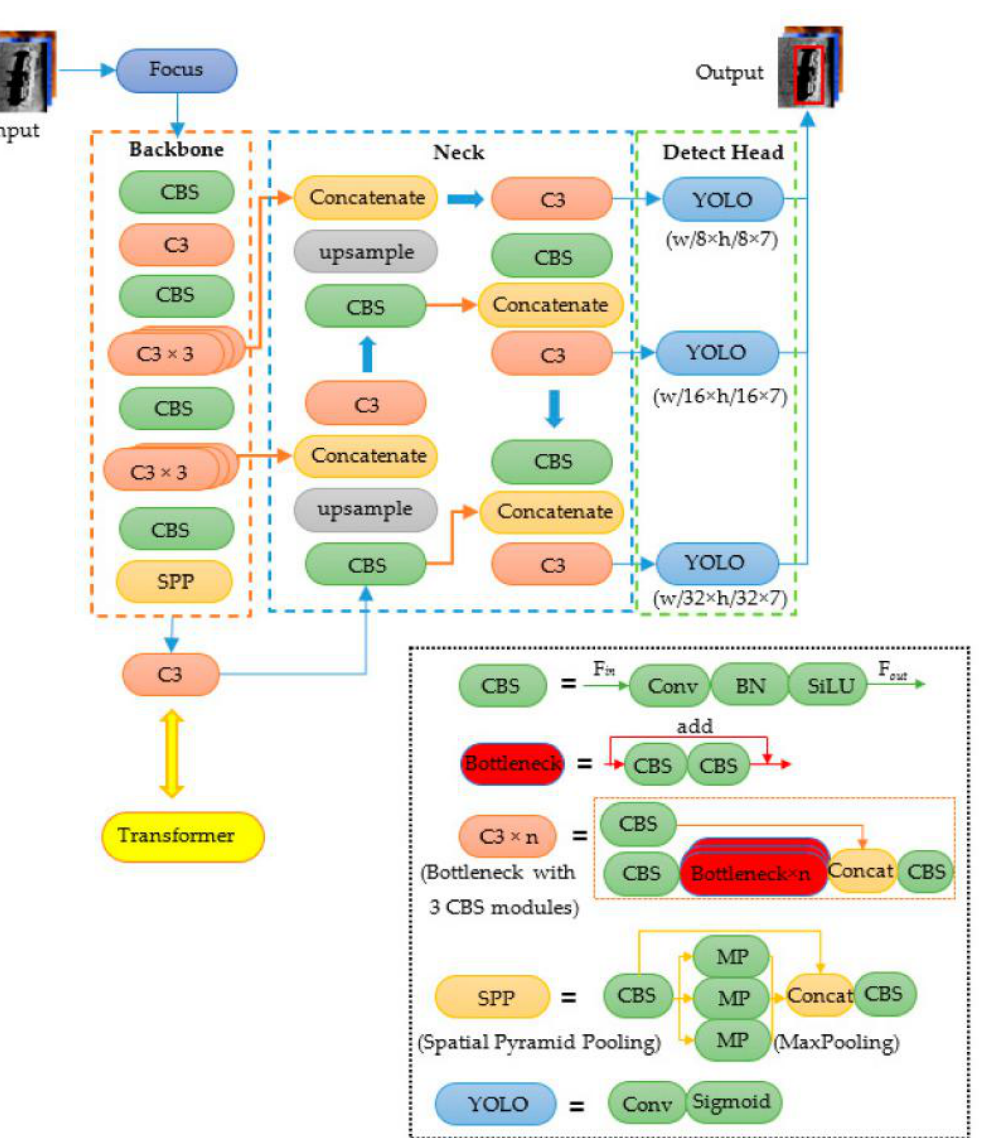
Figure 6. The architecture of TR–YOLOv5s including the raw YOLOv5s and the transformer module marked in